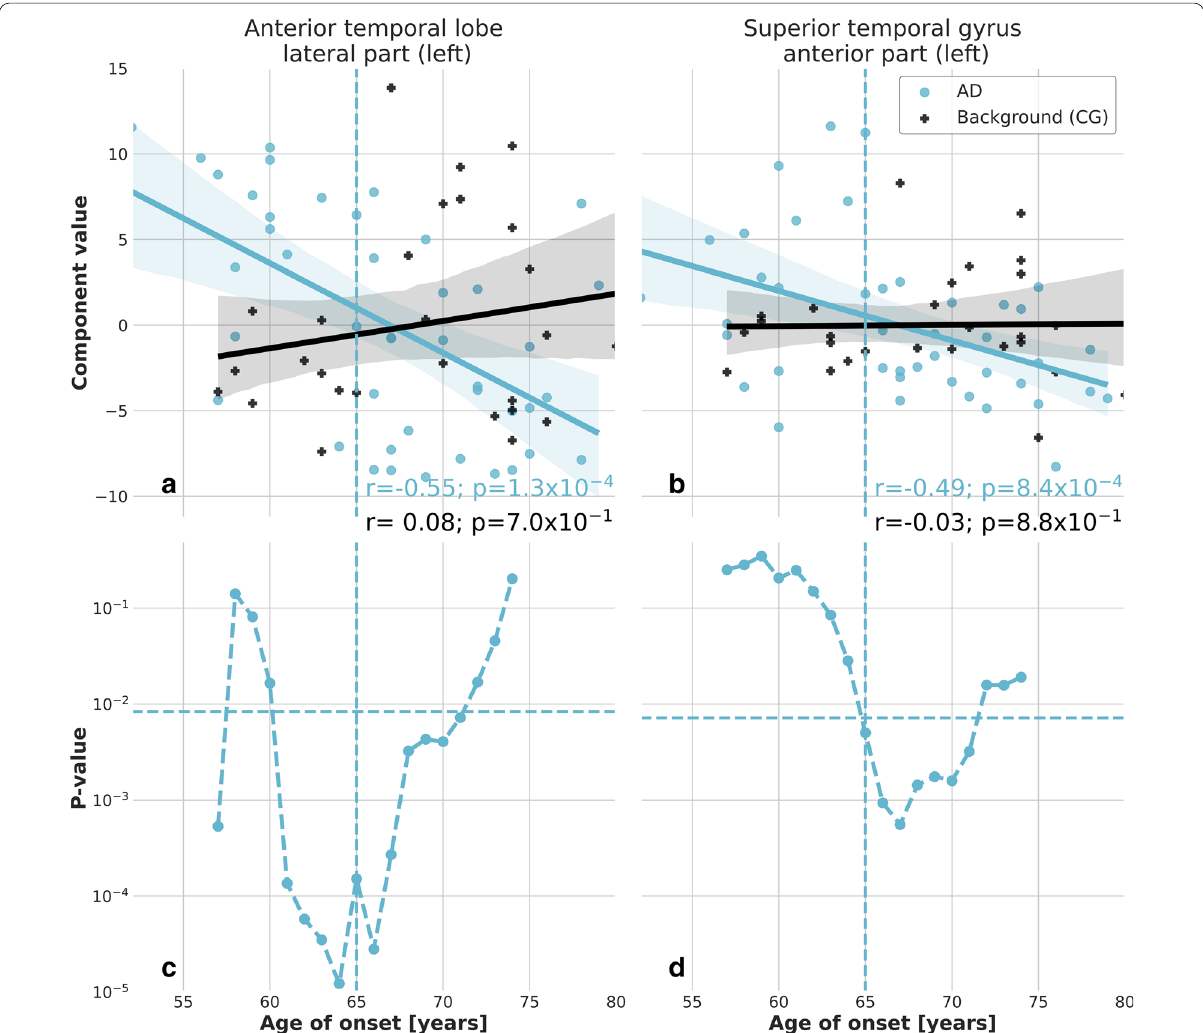
Fig. 4 Correlation of the significant principal components and age of onset of AD in the temporal lobe. Principal components exhibiting significant correlation with the age of onset of AD (cid:31) | r | > 0.5 ; P < 0.05 / N r ind (cid:30) . A linear regression with 95% confidence bands is shown on the plots for better visualization of the correlations. The features extracted from AD patients in the left lateral part of the anterior temporal lobe ( a ) and in the left anterior part of the superior temporal gyrus ( b ) exhibit a significant difference with respect to the background estimated from control subjects, as confirmed also by the Student’s t -test on the distributions of the two patient categories with respect to a threshold age A ( c , d